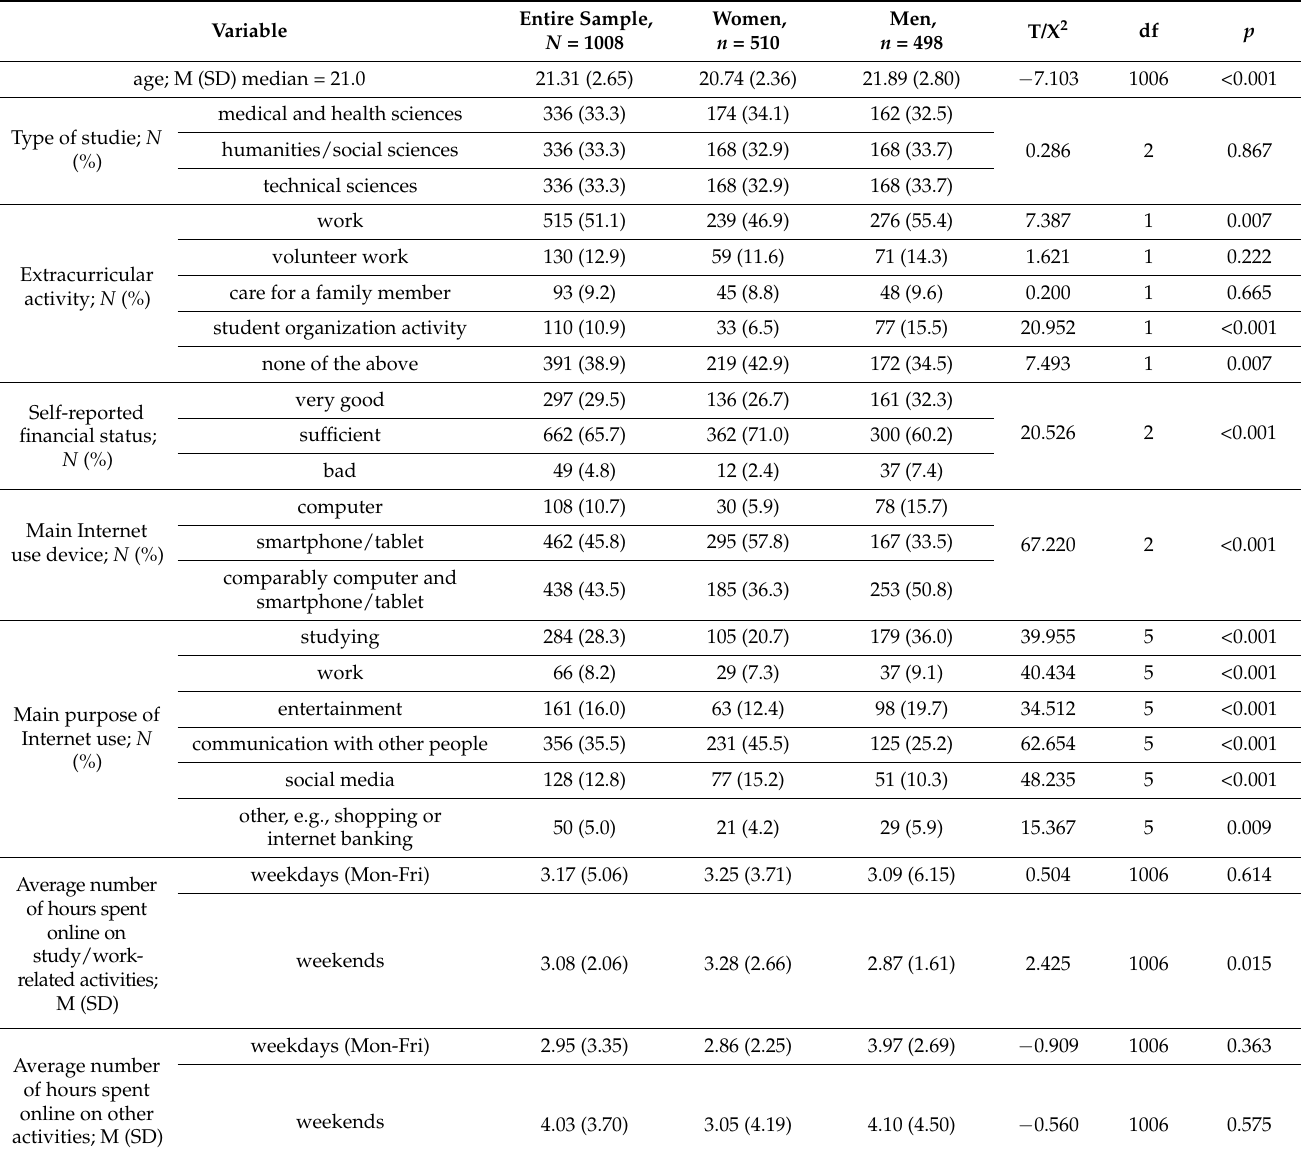
Table 1. Sociodemographic and Internet use characteristics including sex